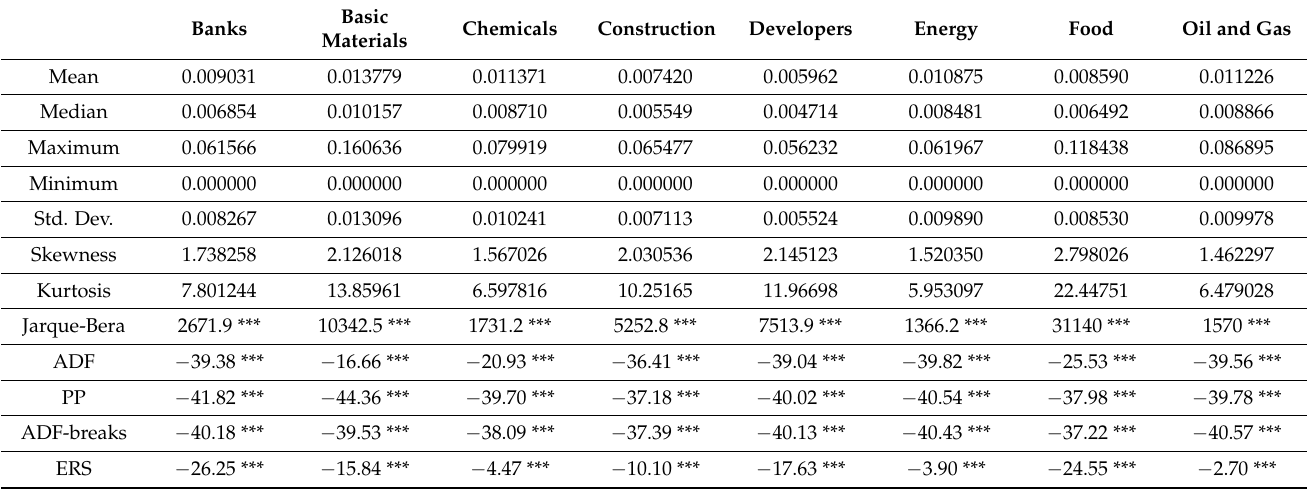
Table 1. Indicators of the descriptive statistics of volatility for the period of 1 January 2013–31